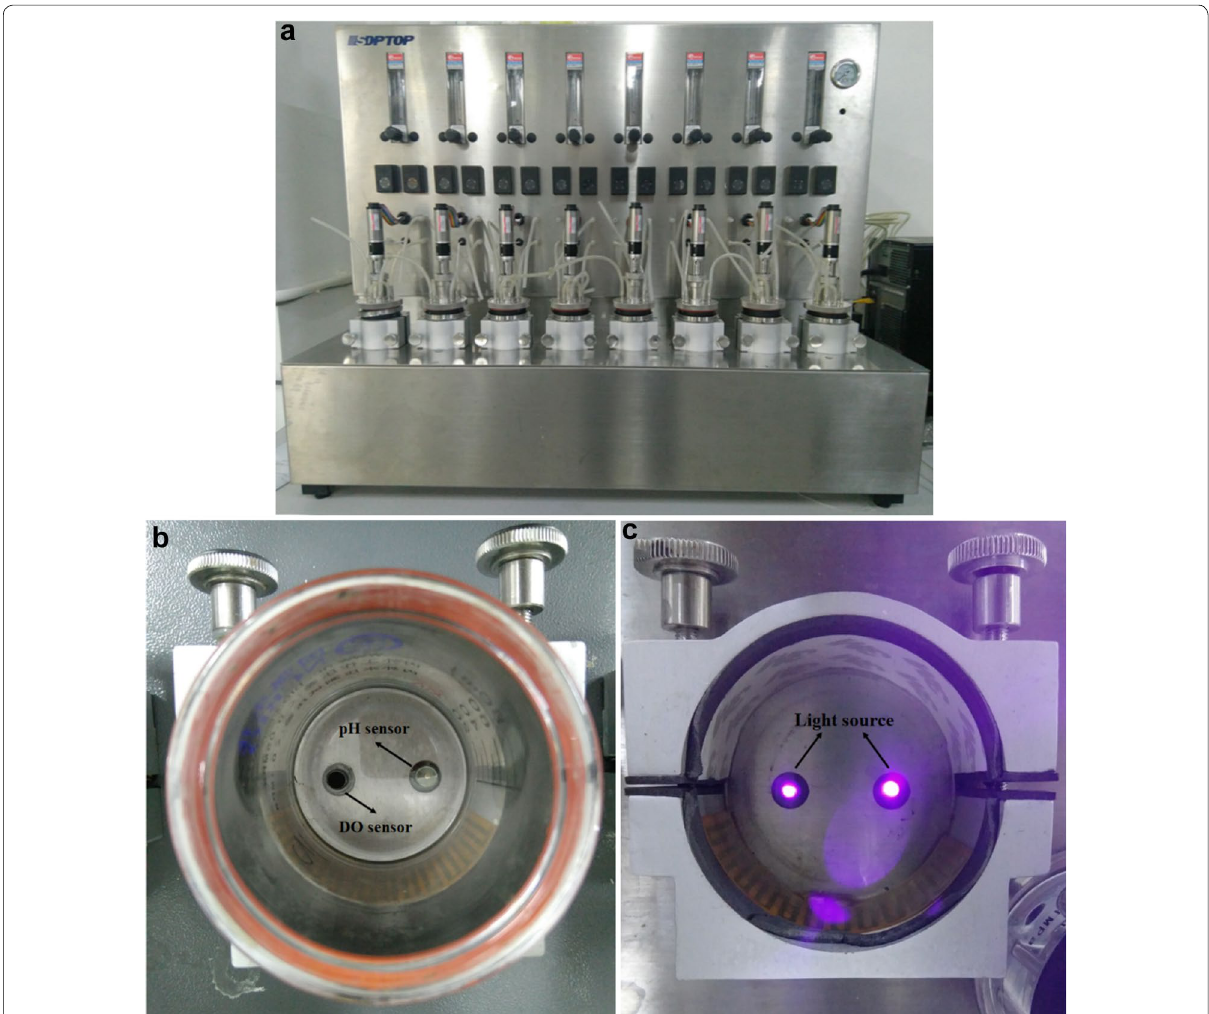
Fig. 1 8-parallel micro-bioreactor system. a General picture; b positions for the optical pH and DO biosensors; c light